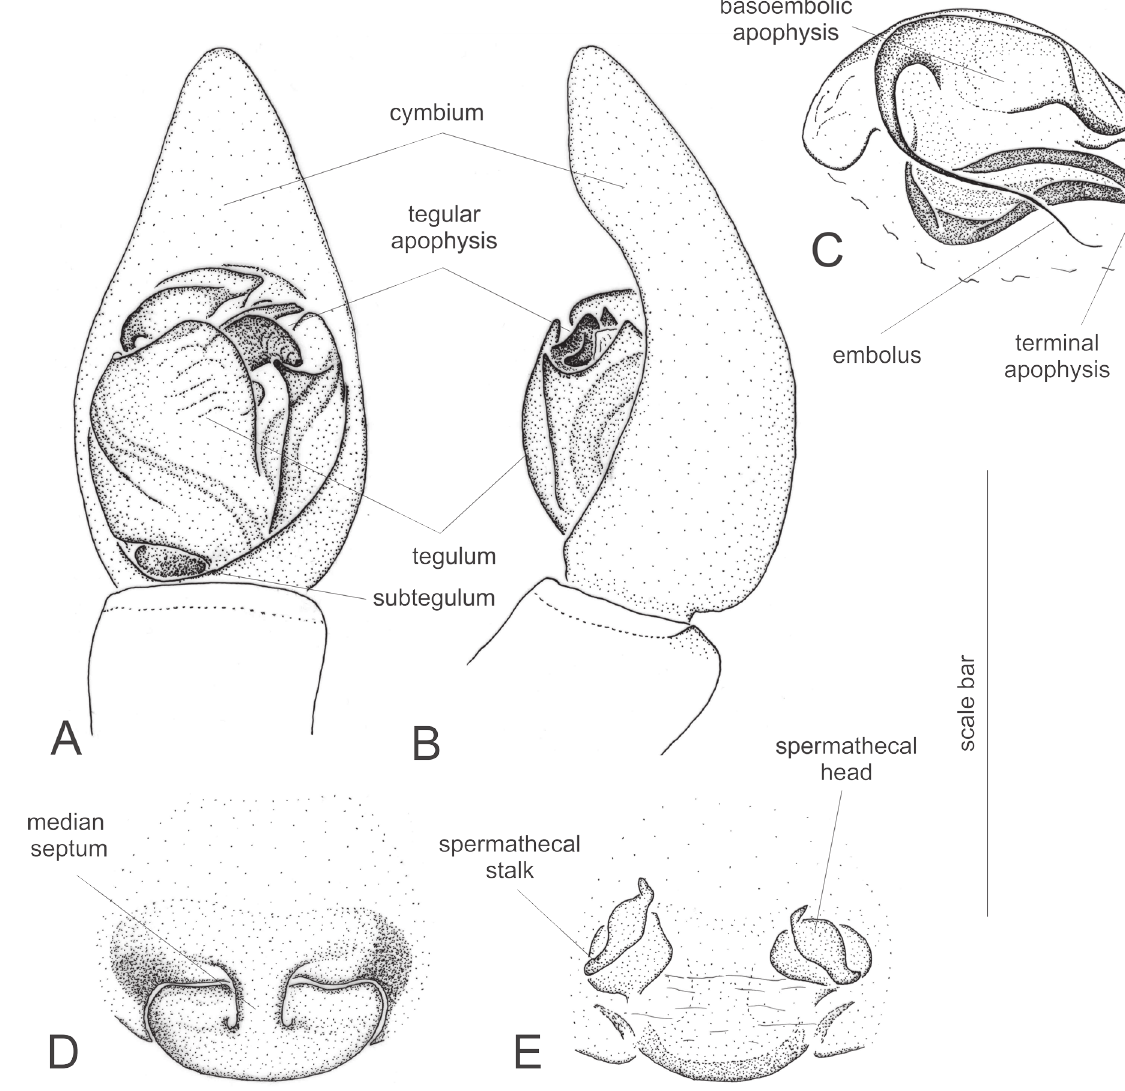
Fig. 11. Tetralycosa orariola sp. nov., ♂, holotype (WAM T62787) and ♀, paratype (WAM T62788). A–B . Left male pedipalp, ventral and retrolateral view. C . Left male pedipalp, palea section of bulbus, ventral view. D–E . Female epigyne, ventral and dorsal views. Scale bar: A–B = 1.09 mm; C = 0.57 mm; D–E =